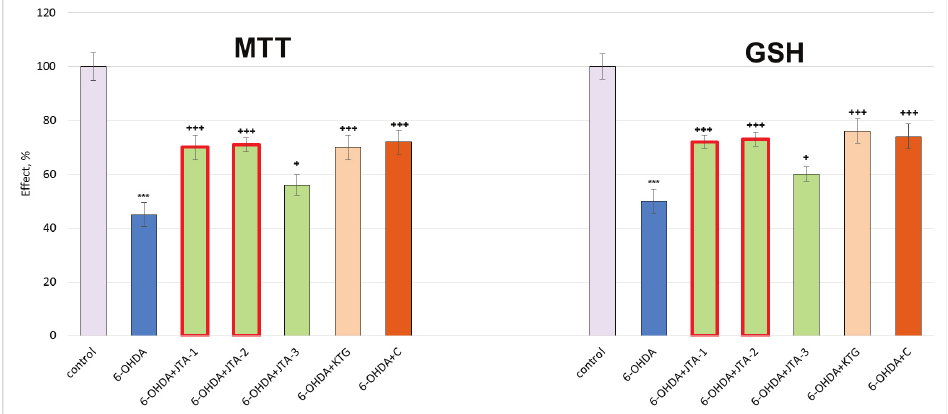
FIGURE 6 - Effects of JTA-1, JTA-2 and JTA-3 on synaptosomal viability and level of GSH in conditions of 6-OHDA-induced oxidative stress, after 1 h treatment. Mean ± SEM (n = 6). *** P < 0.001 – vs control (non-treated synaptosomes); + P < 0.05; +++ P < 0.001 – vs toxic agent